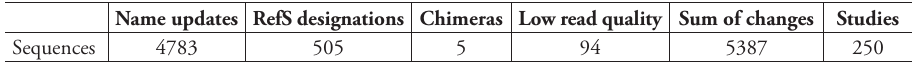
Table 2. Results of the taxonomic annotation part of the workshop. Name updates = number of se- quences whose names were updated. RefS designations = number of reference sequences designated for individual SHs. Chimeras = number of chimeric sequences identified. Low read quality = number of sequences marked as being of substandard technical quality. The chimeras and the low read quality se- quences were excluded from further use in UNITE (although kept in the system for future reference). Studies = number of distinct studies that saw at least one change to at least one